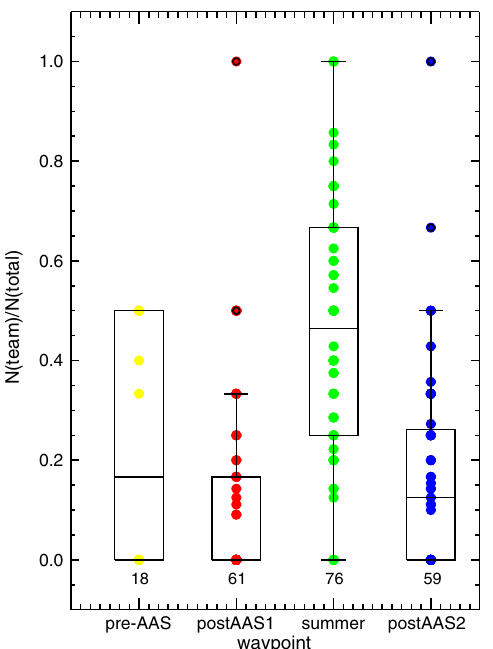
FIG. 4. The distribution of the fraction of team encoded words at each of the four waypoints. Notation is as in Fig. 3. Significantly more people focus on team-related comments after the summer visit than at any other